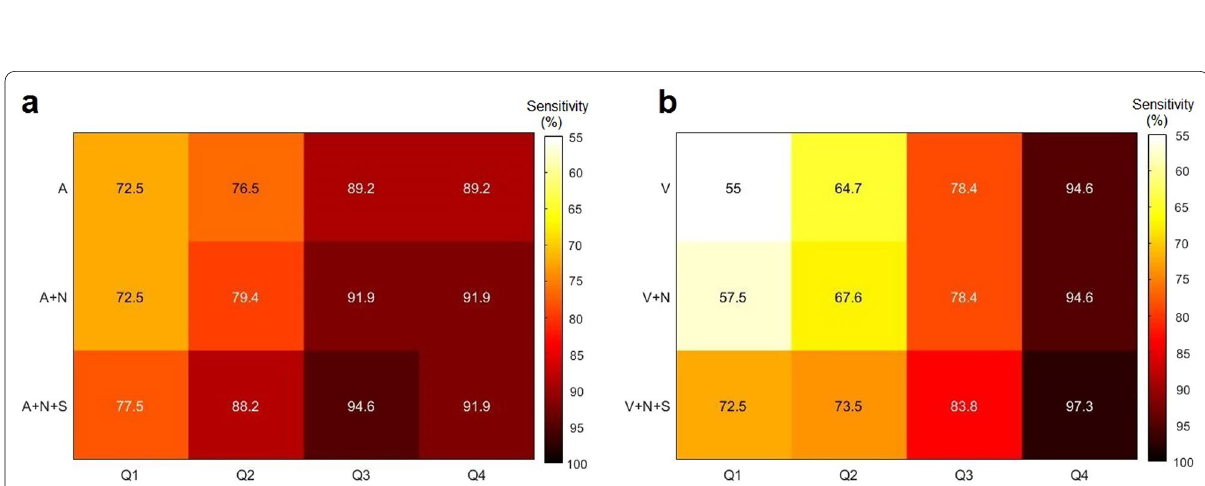
Fig. 5 Sensitivity heatmap for parathyroid adenoma localisation based on either arterial‑based image sets ( a ) or venous‑based image sets ( b ) for different adenoma weight quartiles (upper limits for Q1, Q2 and Q3 are 200 mg, 315 mg and 609 mg,